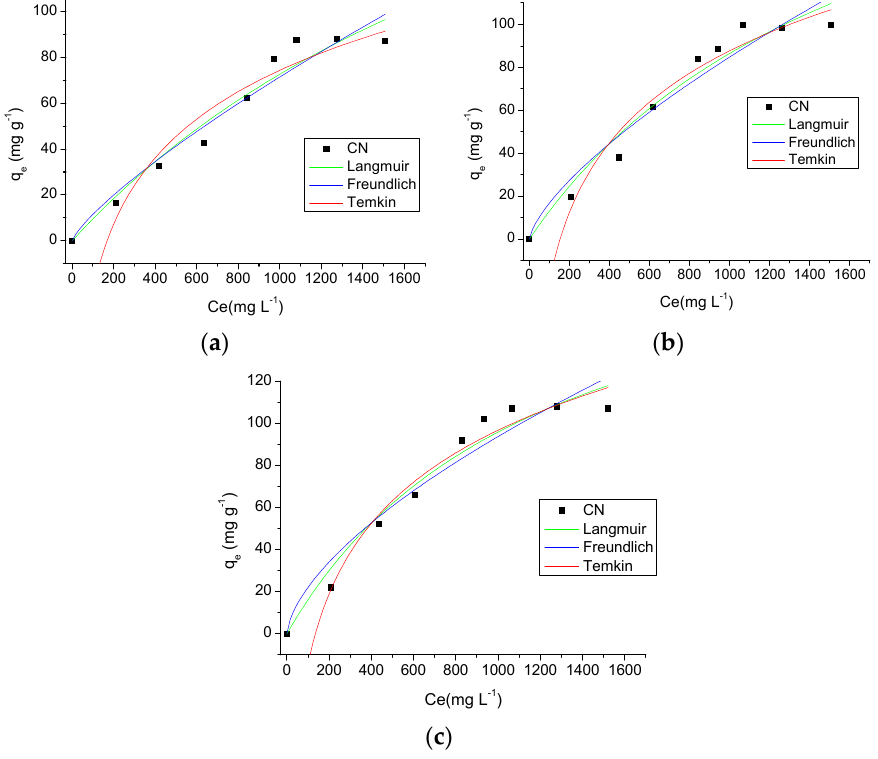
Figure 9. Effect of concentration and temperature (298 K ( a ), 308 K ( b ) and 318 K ( c )) in the AMI adsorption by CN polymer and theoretical models of isotherms. Table 3. Parameters obtained from Langmuir, Temkin and Freundlich isotherm models to AMI adsorption by CN polymer at 298 K, 308 K and 318 K, pH 7 and saturation time of 300 min. Model